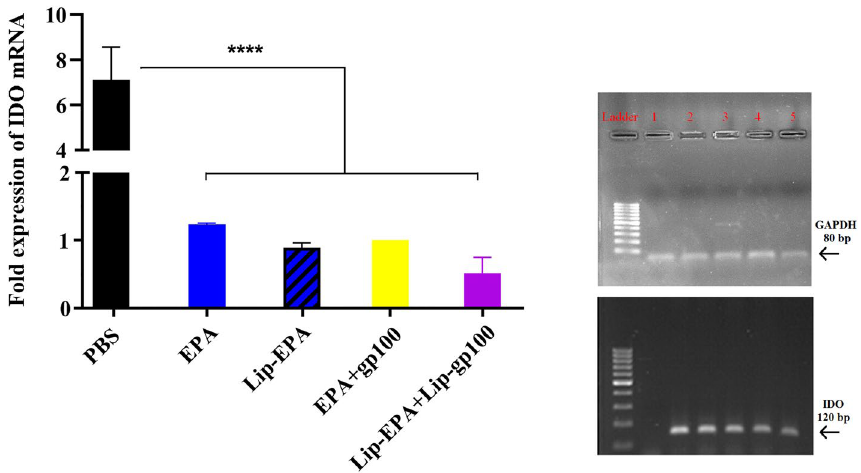
Figure 7. The relative changes in mRNA expression level of the IDO gene in the different treatment groups. Real-time quantitative PCR was used to quantify IDO mRNA expression level in tumor site relative to housekeeping gene, GAPDH. Quantitative results are expressed as the mean ± standard deviation (n = 3). ****p <